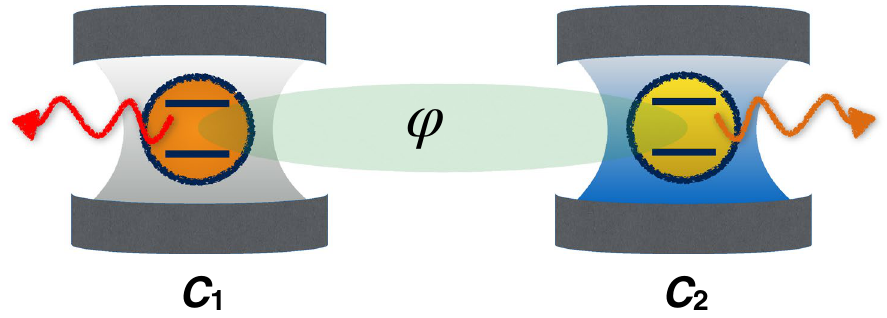
Figure 2. Sketch of two separated identical qubits each one interacting with its own zero-temperature 1, 2 ). The initial state of the two qubits is such that a relative phase parameter ϕ appears dissipative cavity C i ( i = between two-qubit basis states. This figure was created using Keynote, version 10.3.9 (7029.9.8), URL: https:// apps. apple. com/ it/ app/ keyno te/ id409 183694? mt=